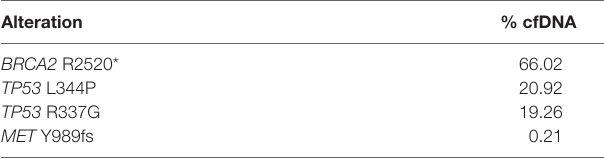
taBLe 1 | Alterations identified in cfDNA in the patient.